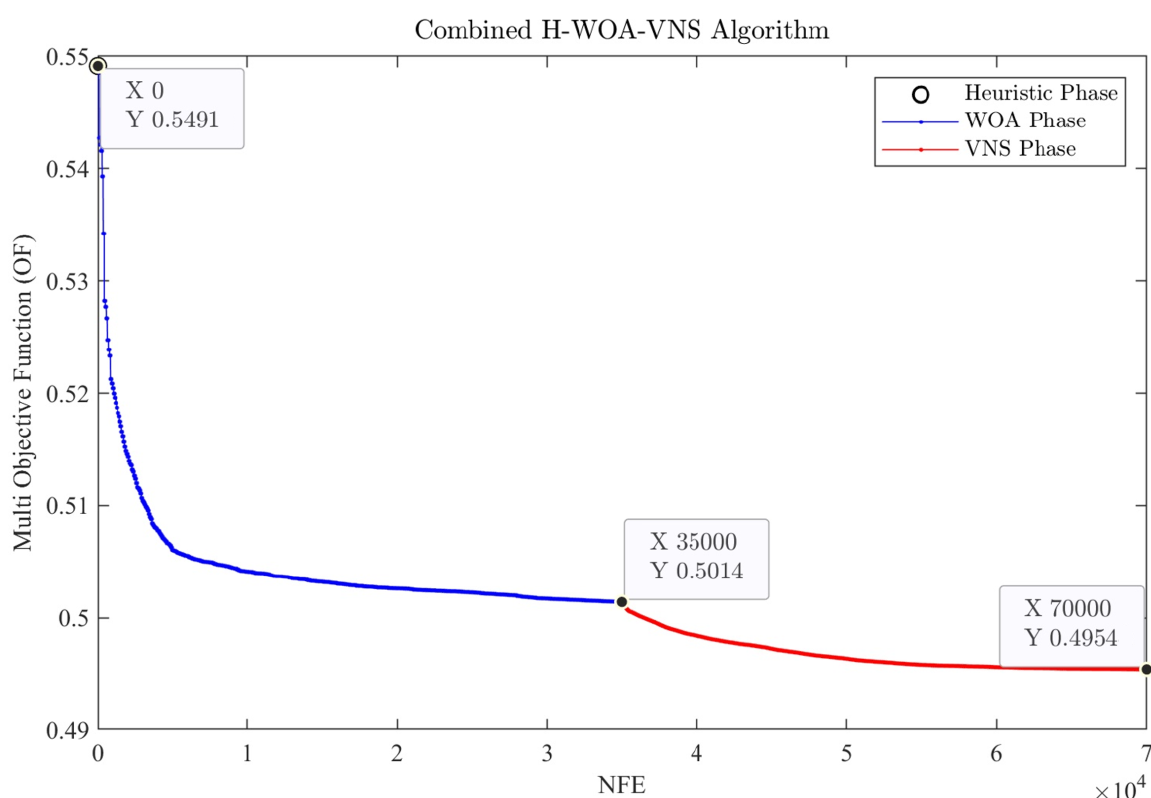
Figure 7. Convergence of the H-WOA-VNS algorithm in terms of the best OF versus NFE. Table 8. Results of the H-WOA-VNS algorithm in 10 successive runs to solve the sustainable PFSCM model for the Case Study.